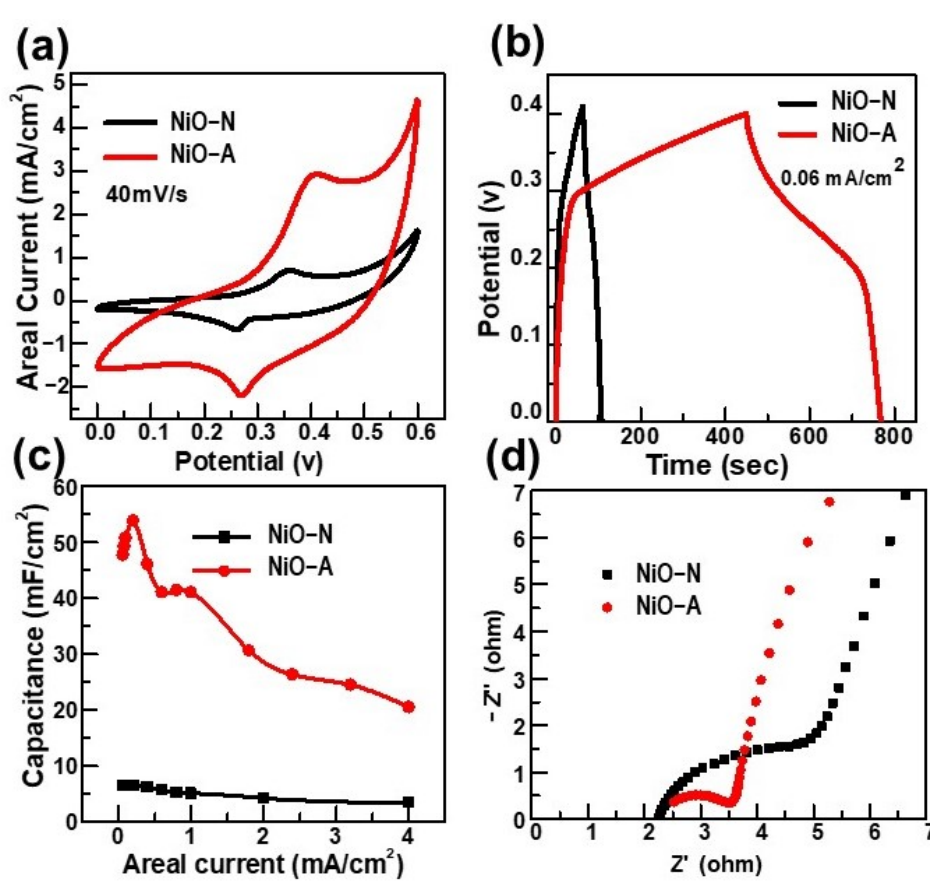
Figure 4. Comparisons of electrochemical storage performance of NiO-N and NiO-A half-cells: ( a ) CV curves; ( b ) CD curves; ( c ) Areal capacitance functions; ( d ) Nyquist plot of EIS.